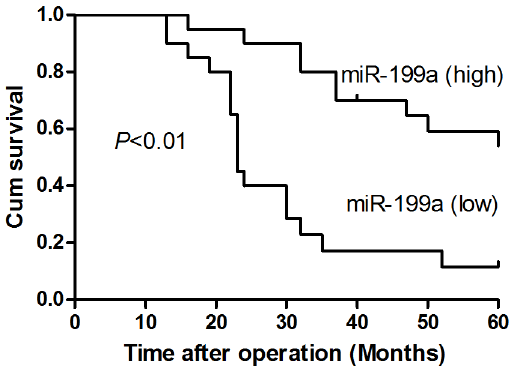
Figure 2. Lower miR-199a expression in HCC tissues is correlated with poorer survival of HCC patients. Five-year cumulative survivals of the HCC patients were analyzed by Kaplan- Meier survival analysis and log-rank tests. The 40 HCC patients were split into high and low miR-199a expression groups based on the median (2.8) for miR-199a. The relative expression of miR-199a in each patient was shown in the supporting information (Table S1).